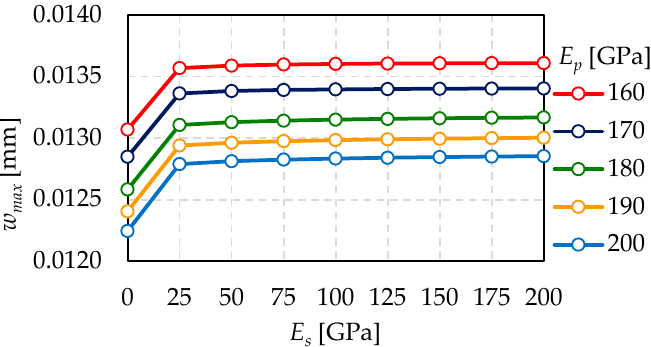
Figure 12. The relationship between maximum glass deflection ( w max ) and sealing Young’s modulus ( E s ) for different pillar Young’s modulus ( E p ).